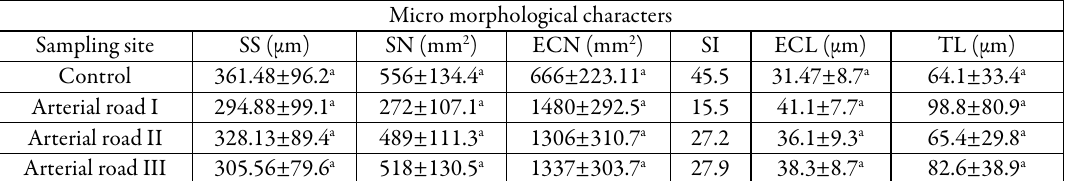
Table 5. Effect of vehicular pollution on micro-morphological variations of Terminalia catappa leaves in the Kumasi Metropolis